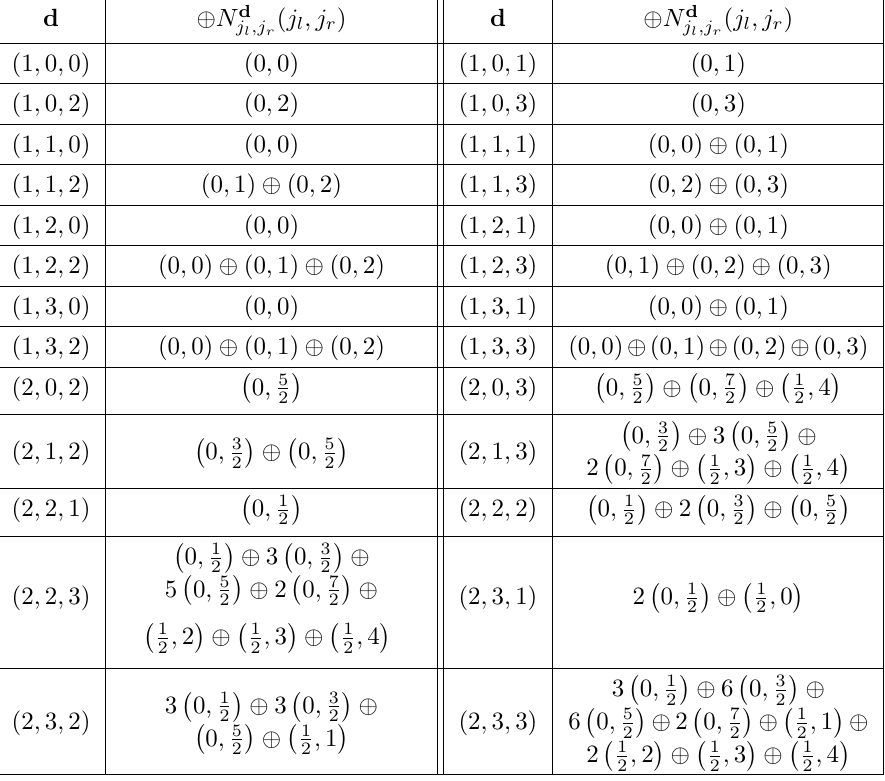
Table 29. BPS spectrum of SU(3) 8 for d 1 ≤ 2 and d 2 , d 3 ≤ 3 . Here, d = ( d 1 , d 2 , d 3 ) labels the state wrapping curve d 1 e 2 + d 2 f 1 + d 3 f 2